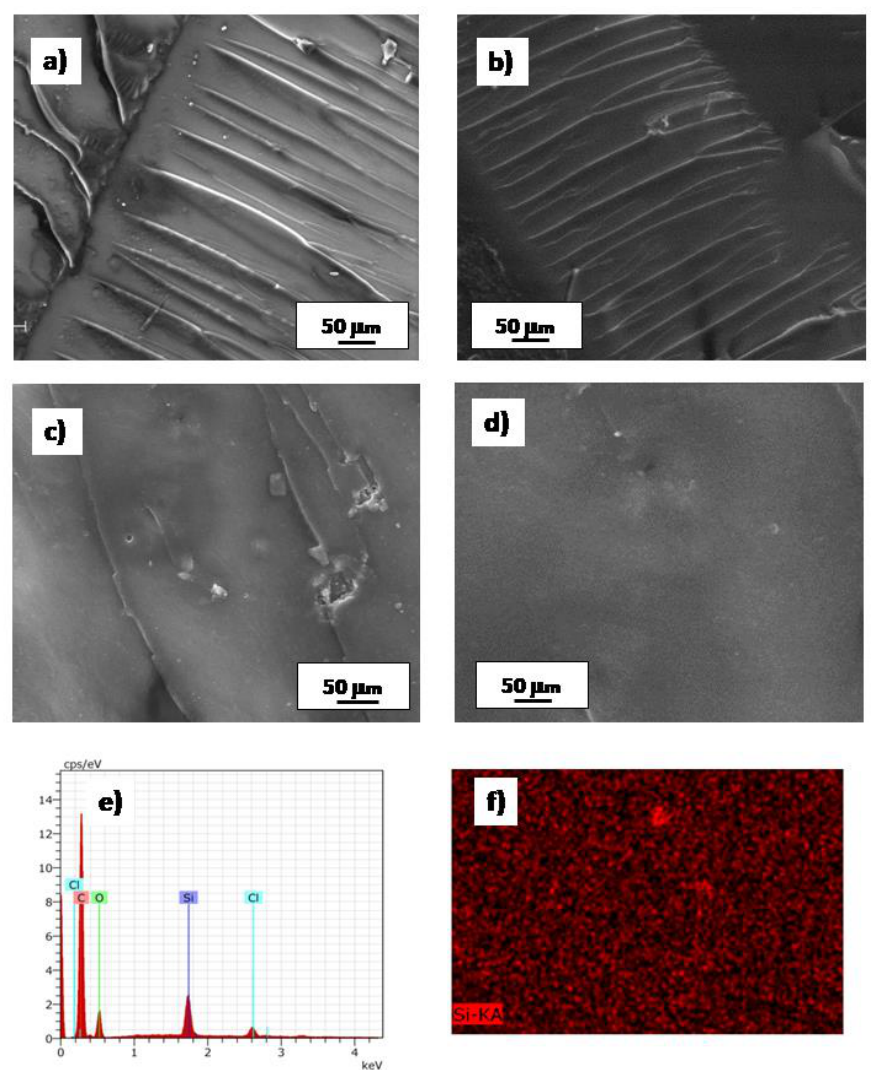
Figure 13. DMTA spectra: (a) Storage Modulus and b) tan delta of neat epoxy resin and of the O-I hybrids based on the same resins, all cured with the cycloaliphatic amine.